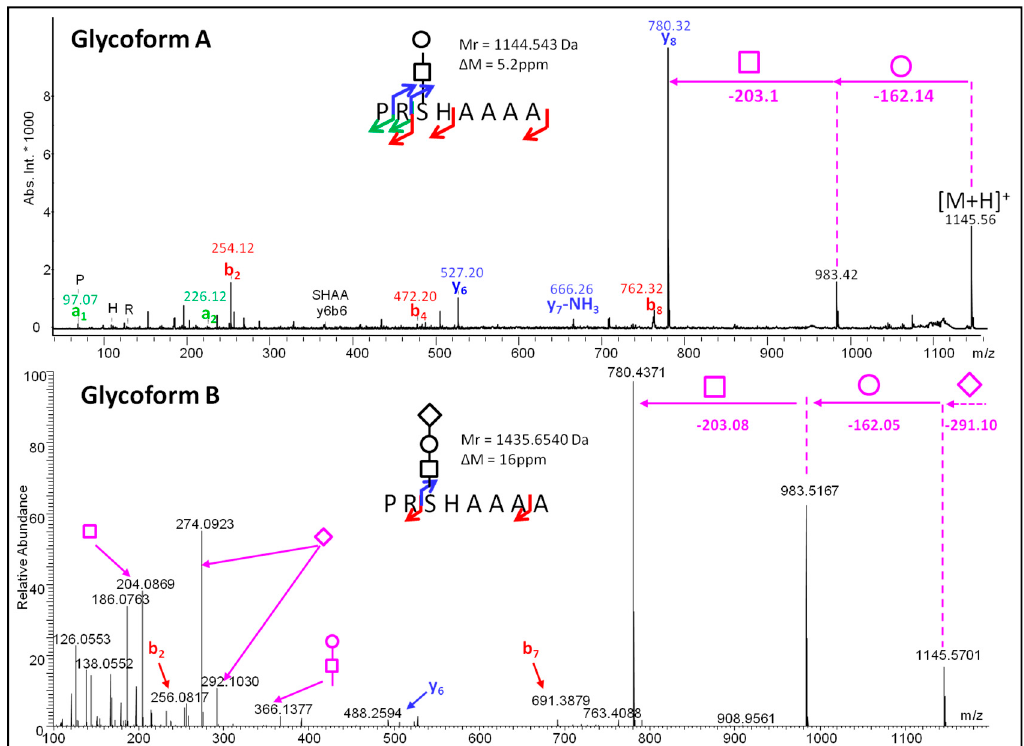
Figure 3. MS/MS spectra of two glycoforms of the same peptide sequence: MALDI-PSD spectrum for glycoform A; nESI-MS/MS spectrum for glycoform B. Arrows indicate fragment ions identified in the mass spectra: a-type in green, y-type in blue and b-type in red. Carbohydrates are represented by the nomenclature proposed by Harvey et al. [13]. Oxonium ions are flagged by arrows.